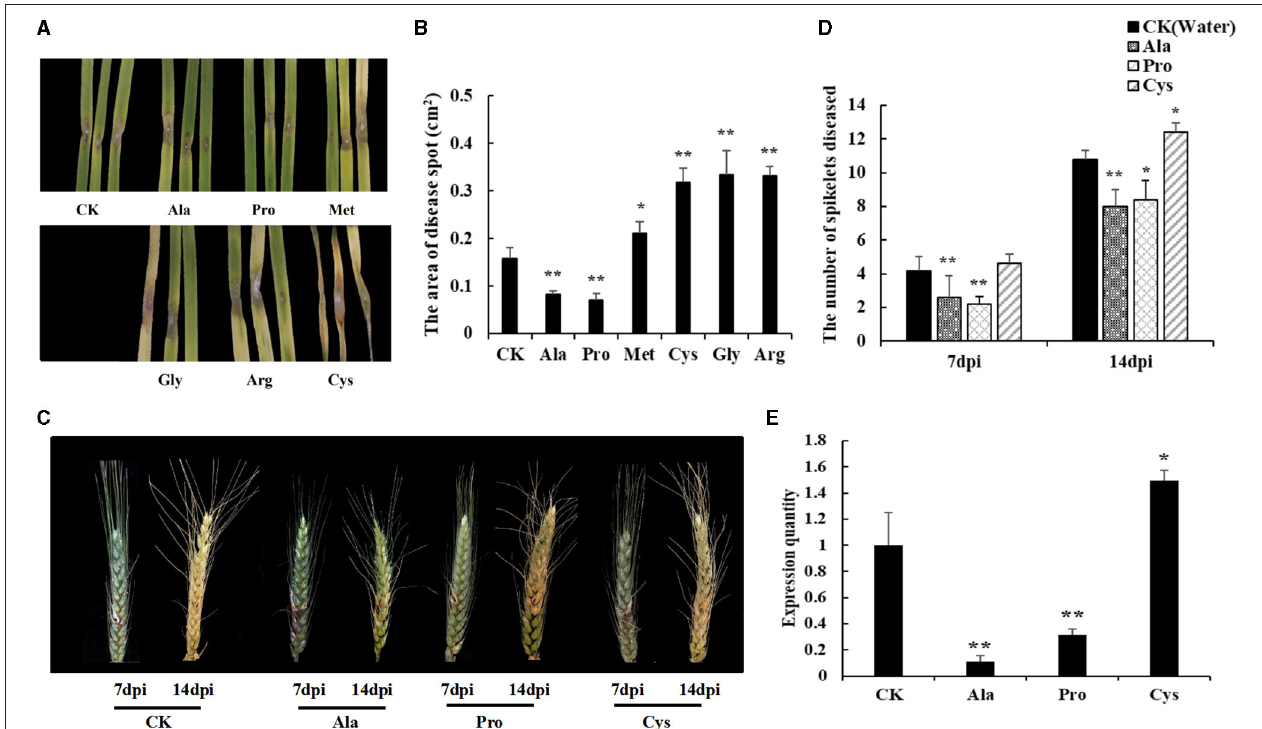
FIGURE 6 | Exogenous amino acid application influences FHB resistance in susceptible genotype wheat. (A) The FHB symptoms of detached leaves dipped with an amino acid solution (10mM). Water was used in mock treatments as a control. Pro and Ala treatment can reduce the disease spots on leaves. Cys treatment lead to leaves becoming more seriously diseased. (B) The area of disease spot in Shannong 20 detached leaves. Pro and Ala treatment disease spot areas were smaller than in water treatment ( P value < 0.05), Gly, Arg, Cys, and Met treatment increased disease spot on leaves compared to water treatment ( P value < 0.01). (C) The FHB symptoms of spikelets sprayed with amino acid solution (10mM). At 14 dpi, Pro and Ala treatment can significantly reduce the number of diseased spikelets, and lighten the phenomenon of spikelets withered in the upper part of the wheat. (D) The number of spikelets diseased. Pro and Ala treatment significantly decreased the treatment at 14 dpi ( P value < 0.05), (E) The biomass quantification of F. graminearum in infected spikelets. Ala and Pro were significantly reduced compared to CK ( P value < 0.05), Cys was increased the F. graminearum relative amount ( P value < 0.05). Student t -test P value: ** P value < 0.01, * P value <